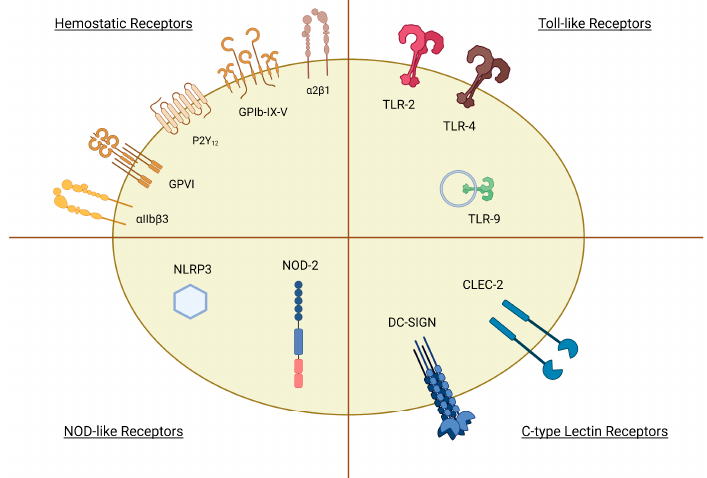
Figure 2. Platelets sense pathogens and host damage through recognition of PAMPs or DAMPs using receptors. Toll-like receptors (TLRs) include surface receptors TLR2 and 4 and endosomal TLR9. NOD-like receptors (NLRs) include NLRP3 and NOD-2. C-type lectin receptors (CLRs) include DC-SIGN and CLEC-2. Haemostatic platelet receptors: GPIb, GPVI, integrin α IIb β 3, P2Y 12 , and integrin α 2 β 1. Created with BioRender.com (Licensing number MY2549P1ZK). These receptors initiate complex and only partially known signal transduction path- ways that cooperate to support the functional role of platelets during infection. Table 3 summarizes the known ligands of platelet receptors involved in the response to infection. Table 3. Platelet receptors involved in pathogen recognition.